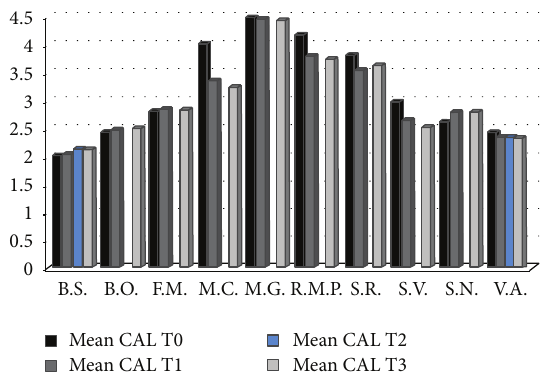
Figure 3: CAL average before and during therapy and type of drug